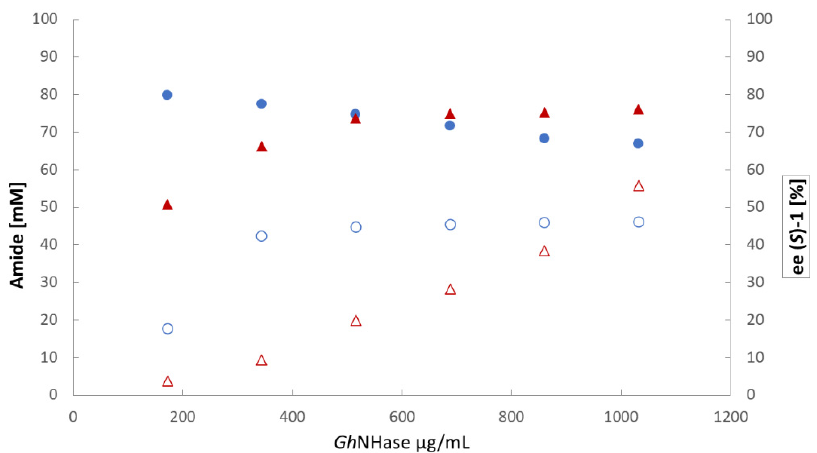
Figure 1. Effect of catalyst amount for the formation of ( S )- 1b by Gh NHase-CFE. The hydrations of 50 mM (dots) or 200 mM (triangles) of ( R , S )- 1a were performed in Tris-HCl buffer (300 mM, pH 7.5) at 25 °C and 500 rpm for 30 min. Filled symbols (top) indicate the ee (right y-axis); empty symbols (bottom) indicate product concentrations (left y-axis) .